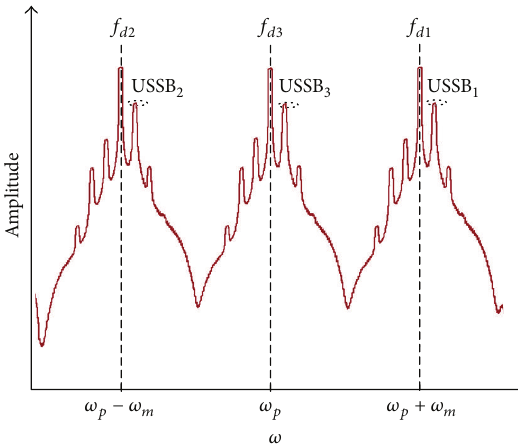
Figure 4: The propagated lightwave signal over the optical fiber.